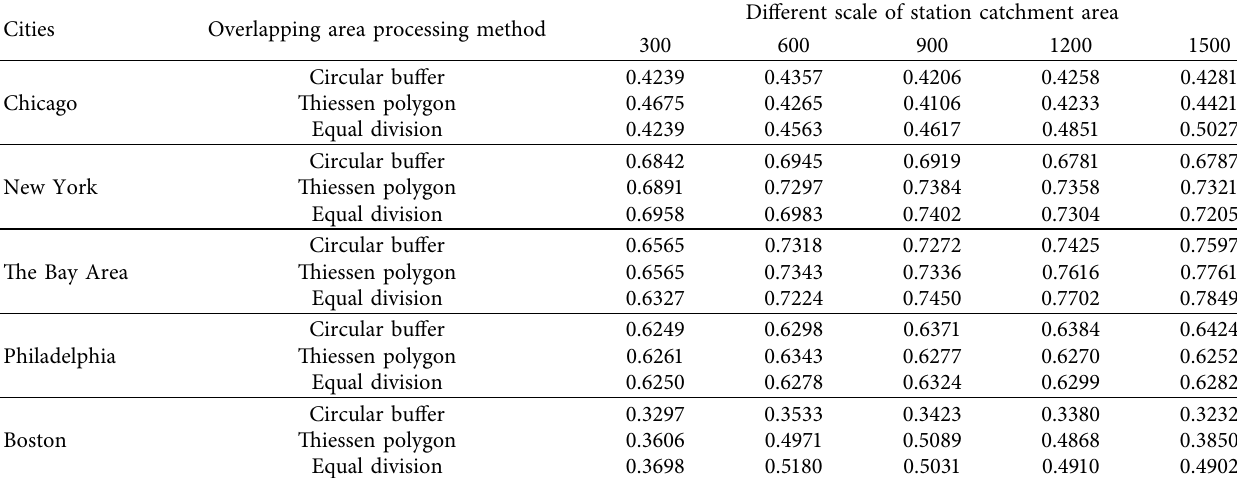
Table 7: Table of the adjusted R 2 of negative binomial regression model in five cities.